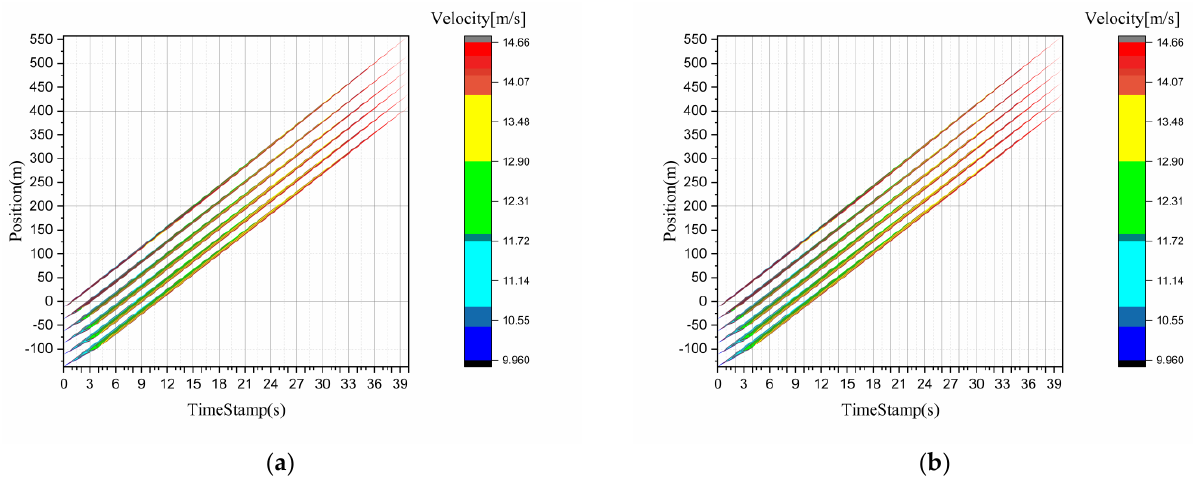
Figure 12. Velocity heatmap of CAVF fleet and CACCNF fleet under scenario 2: ( a ) CAVF velocity heatmap; ( b ) CACCNF velocity heatmap.